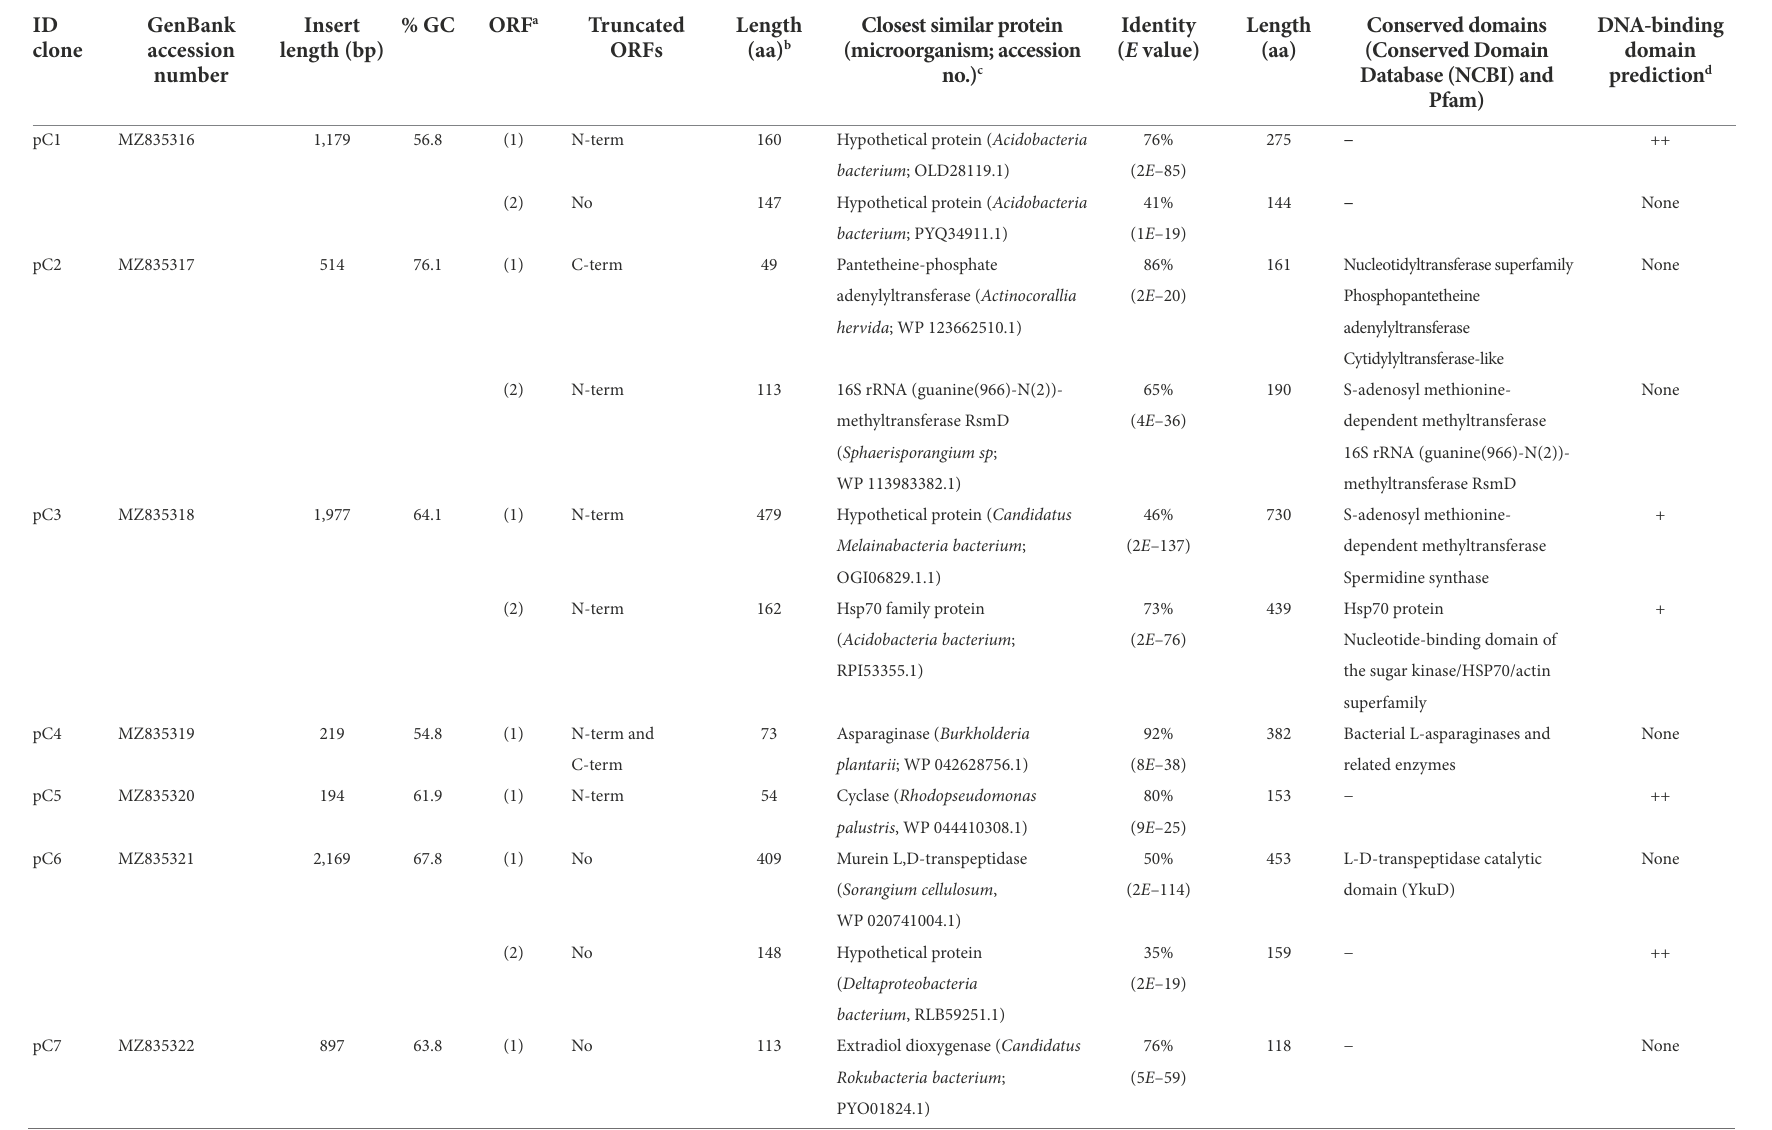
TABLE 1 Description of cold-resistance clones isolated from metagenomic libraries C and D using DH10B csdA and DH10B Δ csdA Δ rnr strains as hosts, similarities with other known sequences and conserved domains found in